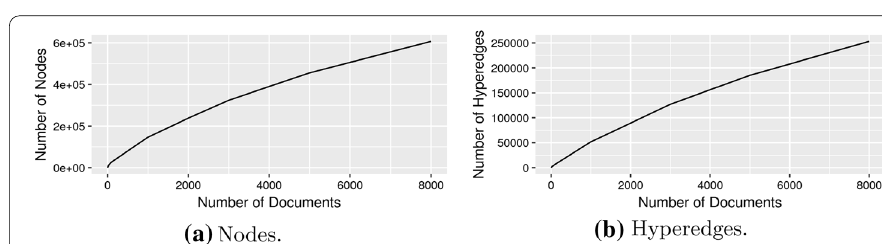
Fig. 8 Number of nodes and hyperedges over time for the base model